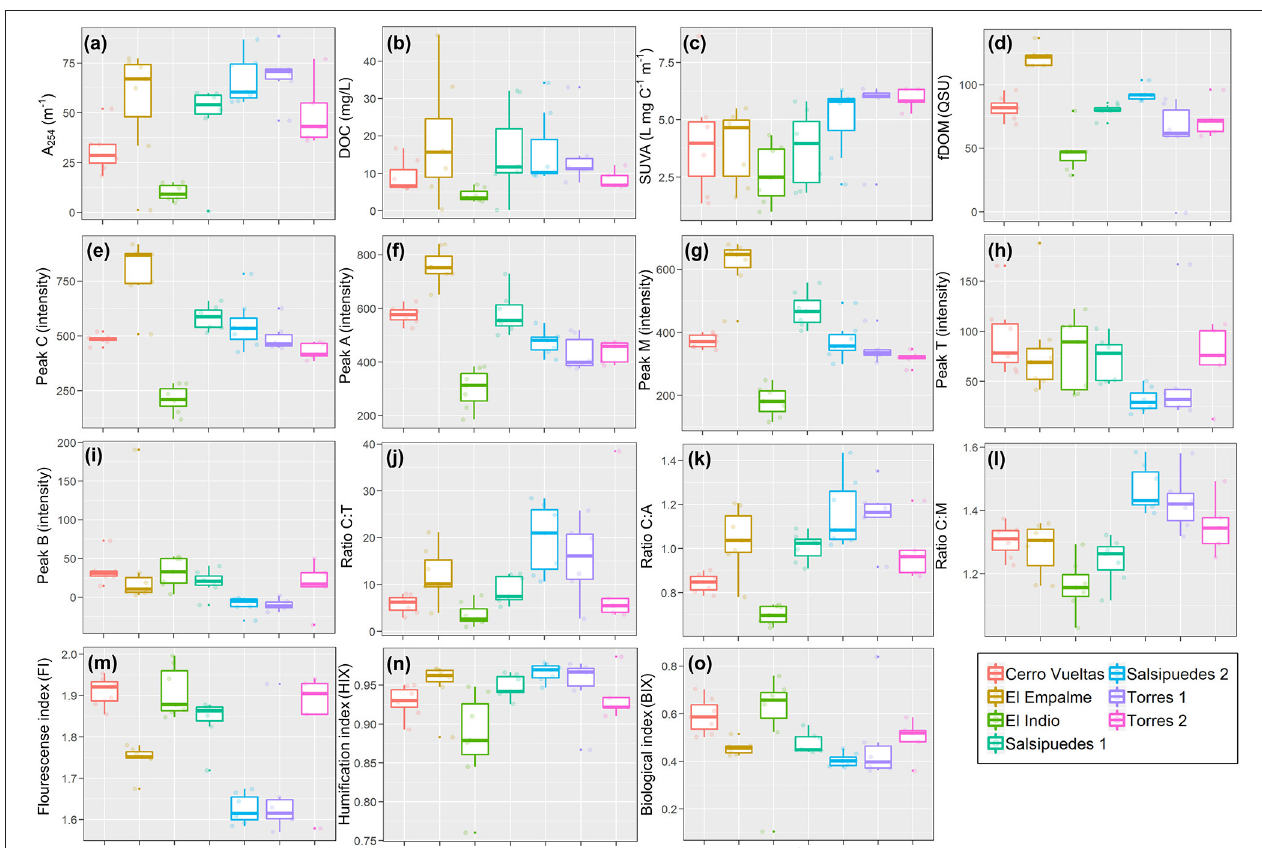
FIGURE 6 | Box plots (with individual data points) of dissolved and optical organic carbon properties, including: dissolved organic carbon (DOC), a 254 , f DOM, SUVA index, Coble’s peaks (C, A, M, T, and B; in absolute fluorescence intensity), and ratios (C:T; C:A; and C:M), fluorescence index (FI), humification index (HIX), and biological index (BIX). Sampling sites are color-coded and plots include 25th, 75th, median, and outliers. El Empalme and El Indio represent the lowest and highest sampling sites, respectively (see Figure 1